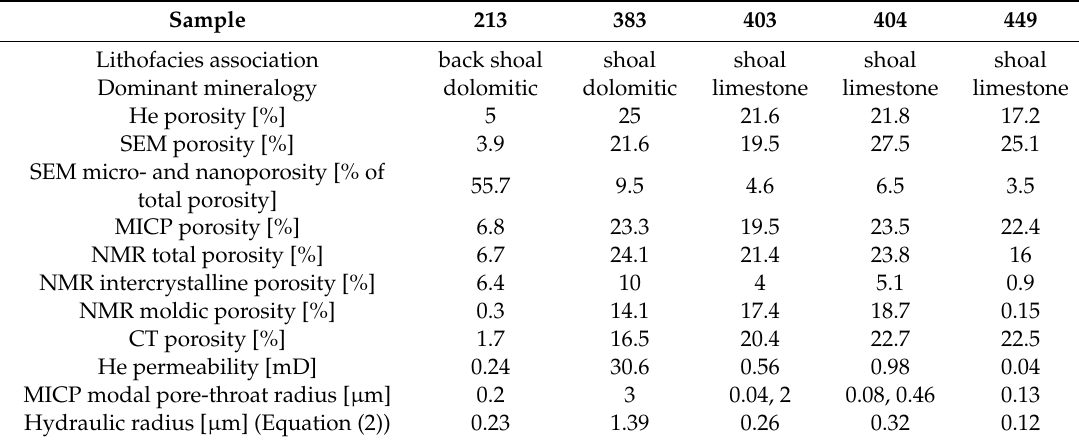
Table 3. Sample porosities, permeabilities, and pore